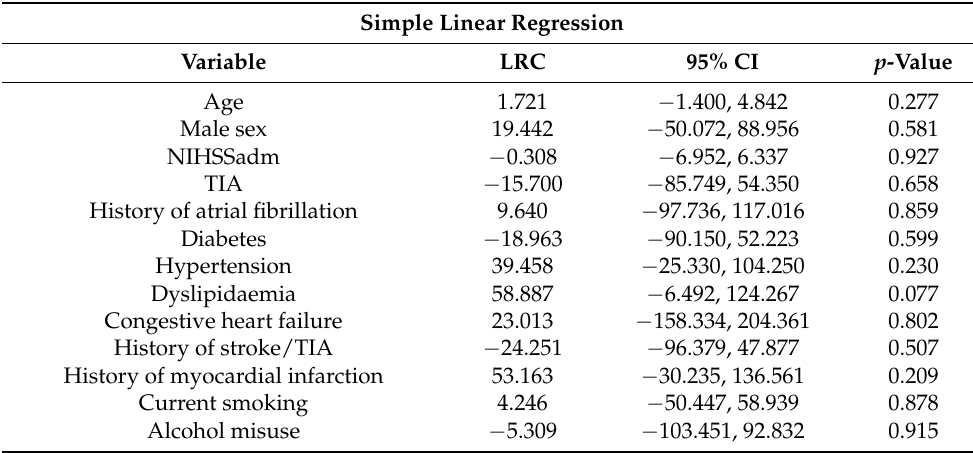
Table 3. Simple linear regression analyses on the associations of vaspin levels with baseline charac- teristics, neuroimaging findings and outcomes in ACI